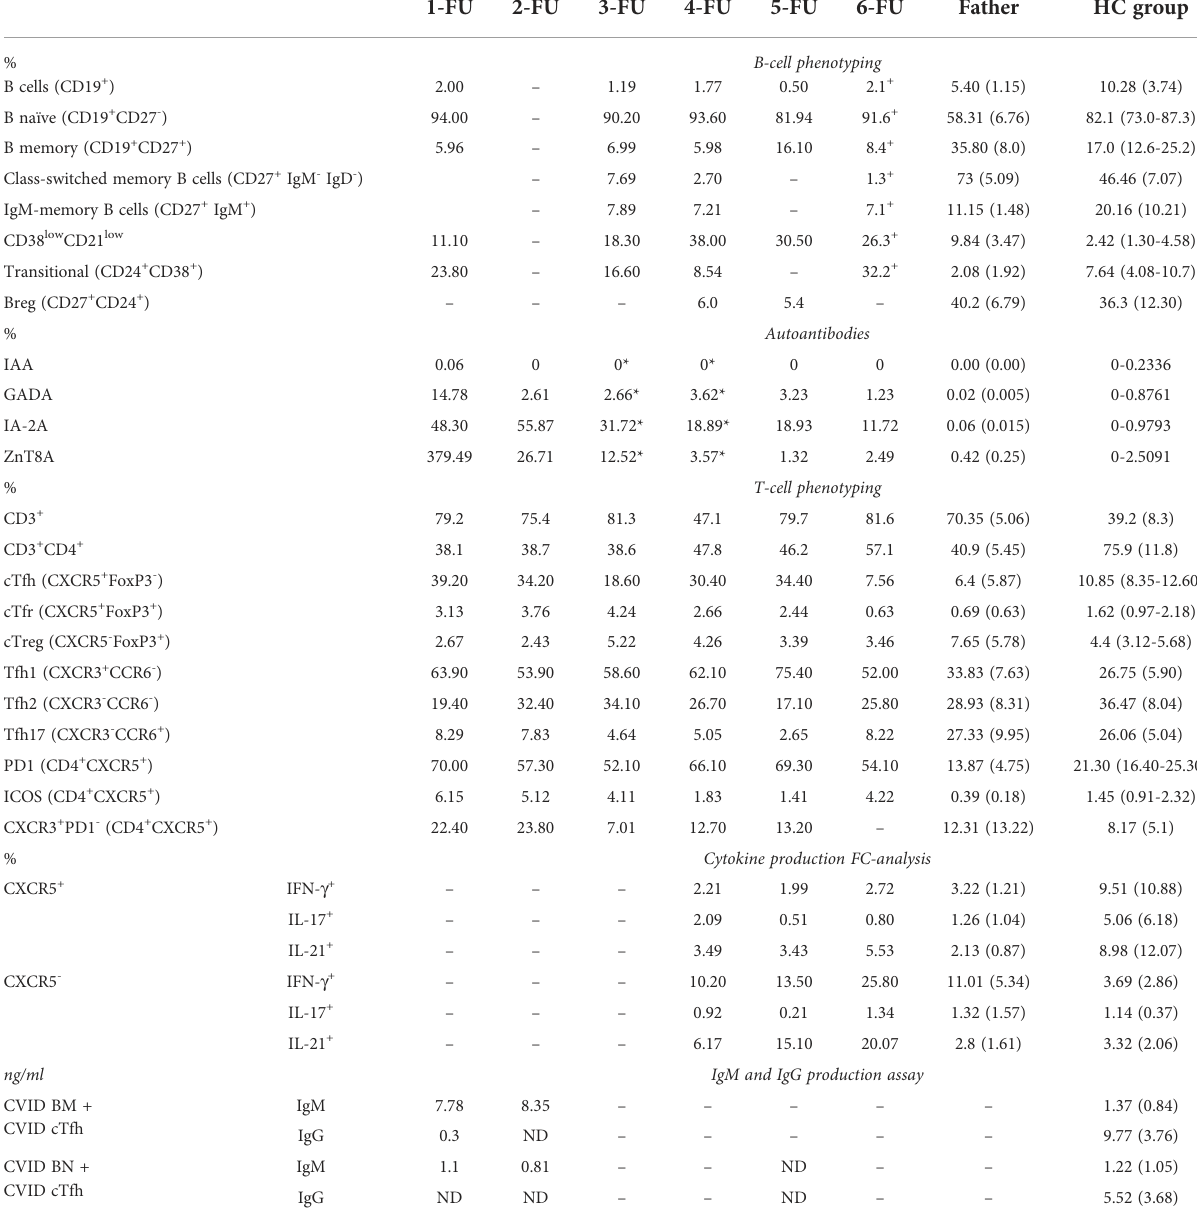
TABLE 1 Immunological phenotyping of B and T cells, autoantibodies titres, and analysis of cytokine production by FC.